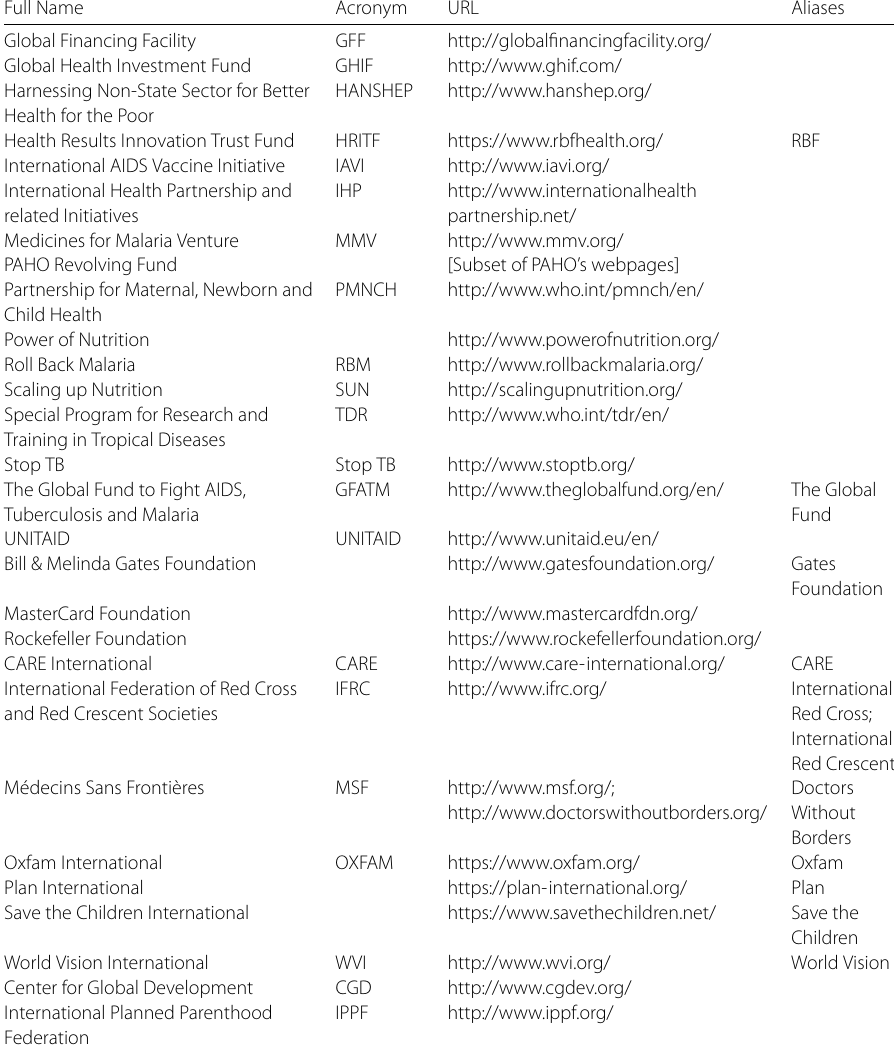
Table A3 The list of issues on which this study focuses AIDS, Avian influenza, Child Health, Communicable Diseases, DAH, Development Assistance for Health, Disease Control, Disease Outbreak, Disease Prevention, Ebola, Family Planning, Global Health, Health Care, Health